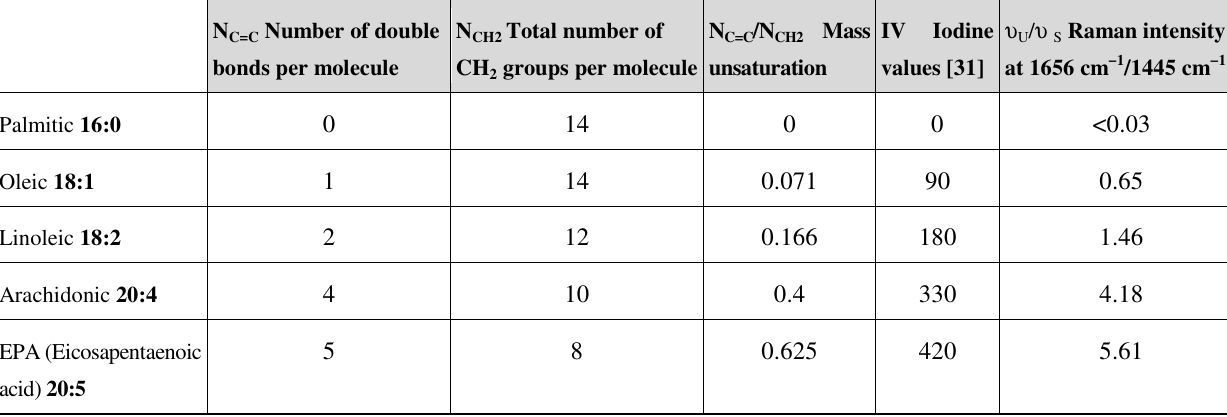
Table 2. Fatty acids used for the calibration of Raman spectral data against the actual mass unsaturation of the molecules and their iodine values. Raman scattering spectra of fatty acids were acquired with 10 s integration time and excitation power of ~13 mW at the specimen.